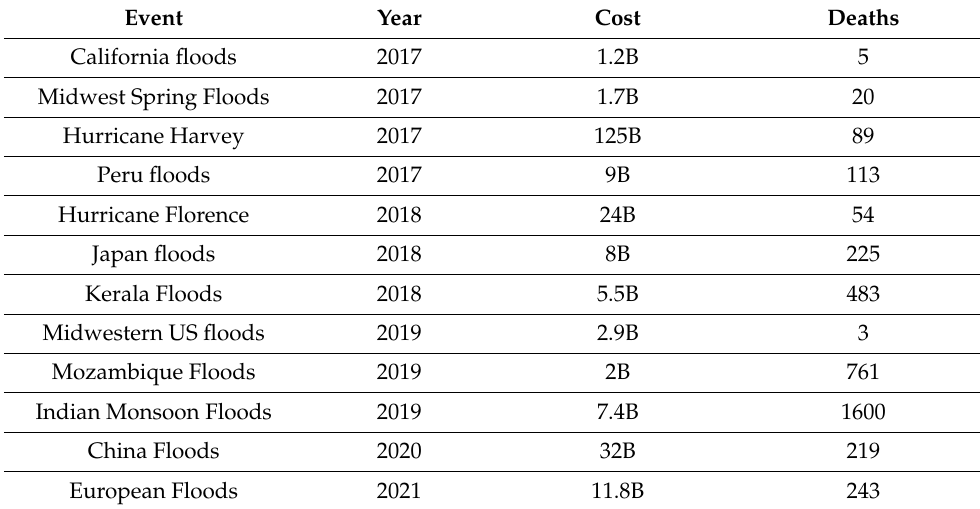
Table 1. Selection of impactful floods from